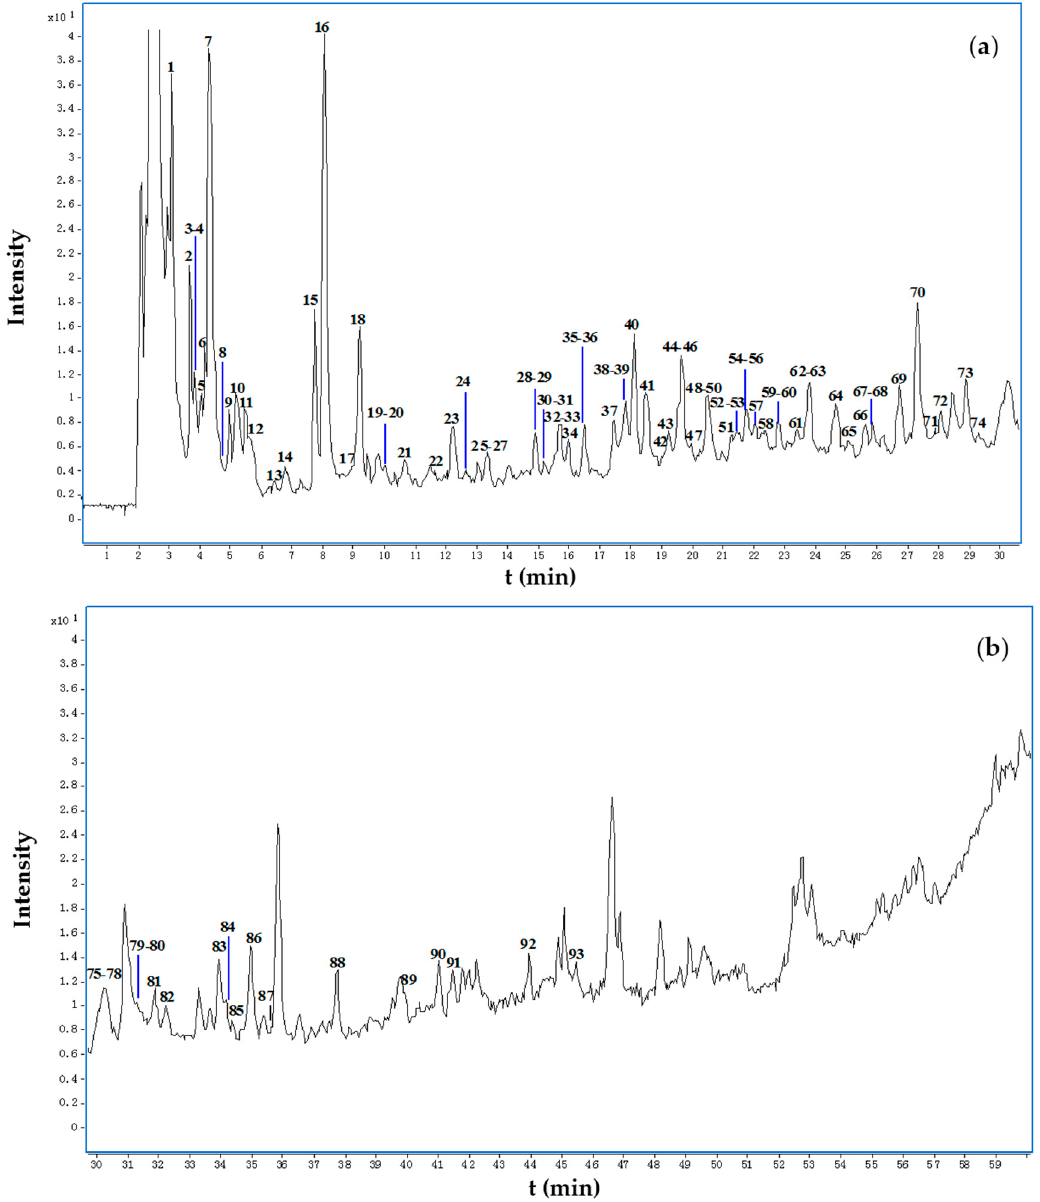
Figure 1. Total ion chromatograms (TIC) in negative-ion mode (from HPLC-ESI-Q-TOF-MS) of the Juglans mandshurica decoction ( a ) within 0–30 min and ( b ) 30–60 min. The peak numbering in each TIC relates to the numbered compounds listed in Table 1.